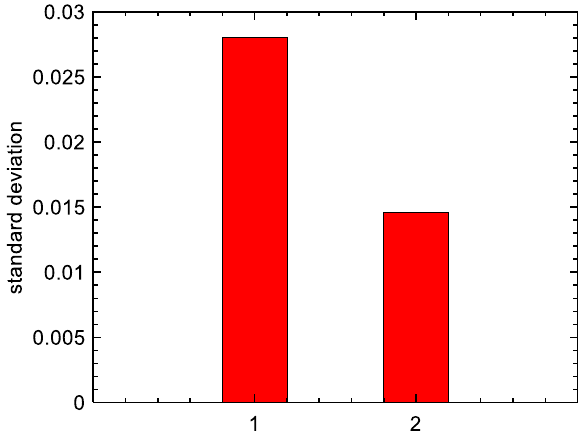
Figure 20. Standard deviation of blade responses (1—original; 2—with dual-connected SSDI).